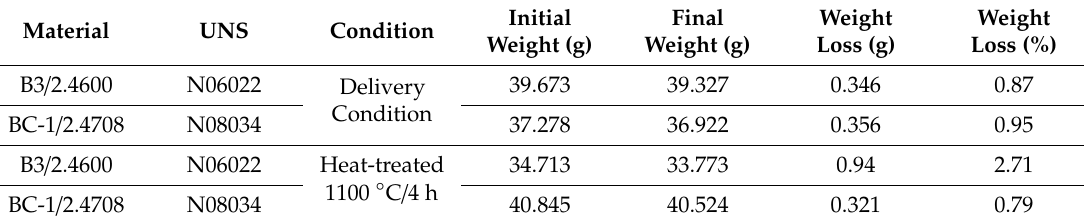
Table 5. Results of corrosion experiments in 95–97% sulfuric